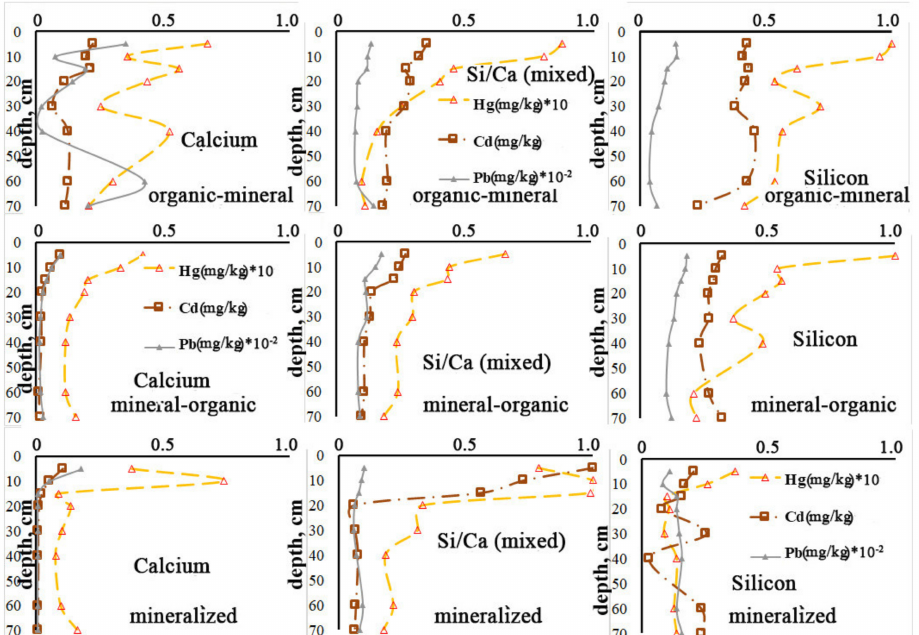
Figure 6. Vertical distribution of the averaged contents of Cd (mg/kg); Hg (mg/kg)*10 and Pb (mg/kg)*10 − 2 in sapropel sediments of various types (organic–mineral; mineral–organic; mineral- ized) and class (Silicon; Calcium, Si/Ca (mixed)) along cores (according to our data).